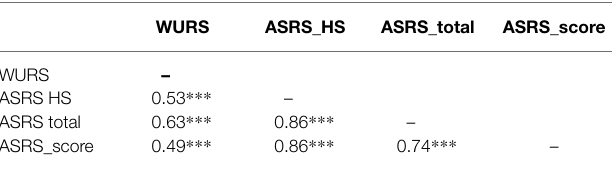
TABLE 4 | Correlation